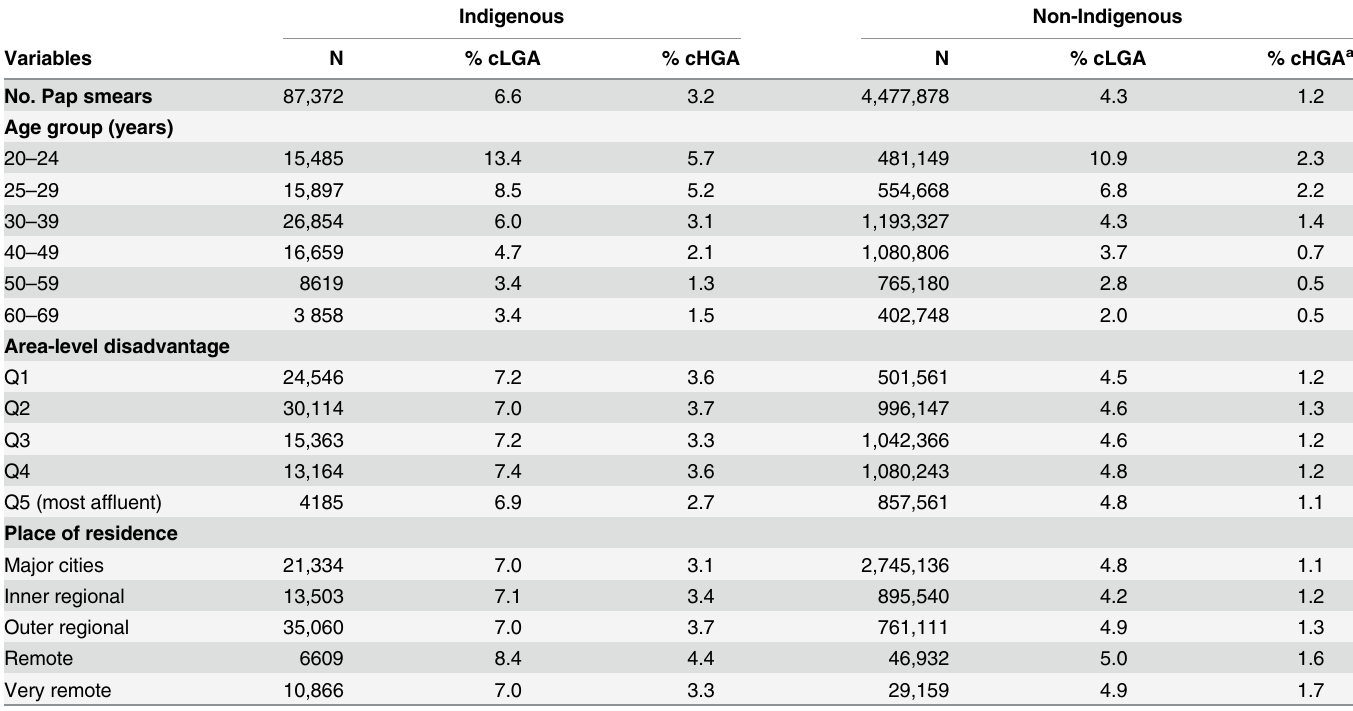
Table 2. Demographic characteristics of Indigenous and non-Indigenous women ’ s Pap smears by abnormality, 2000 –